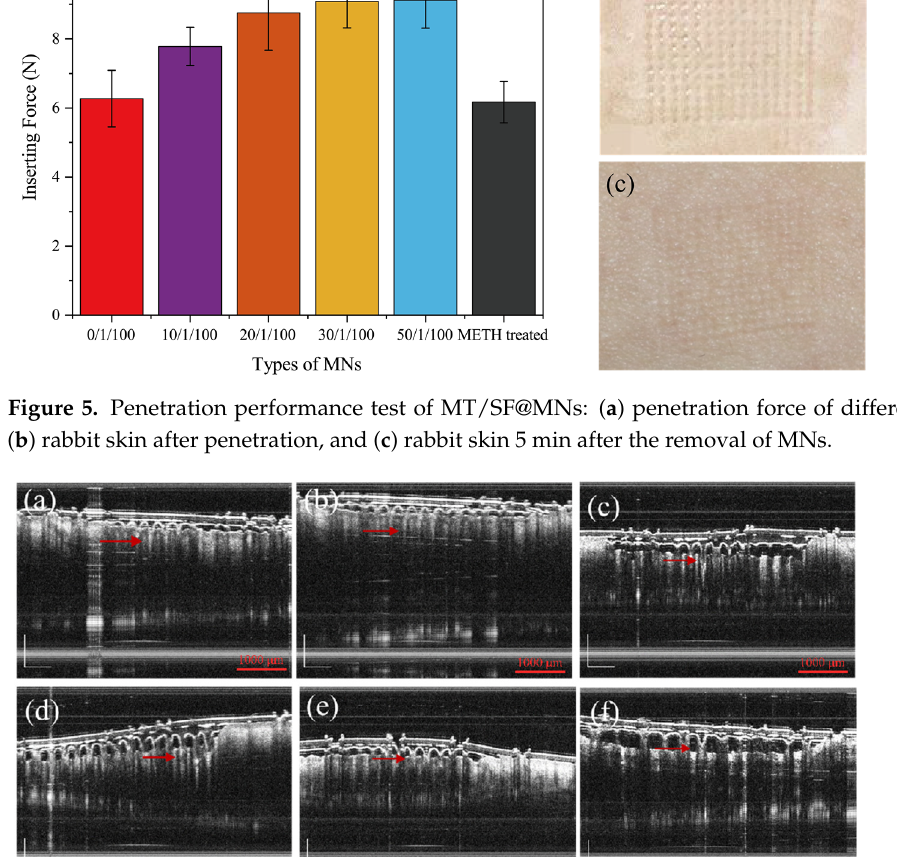
Figure 5. Penetration performance test of MT/SF@MNs: ( a ) penetration force of different MNs, ( b ) rabbit skin after penetration, and ( c ) rabbit skin 5 min after the removal of MNs.